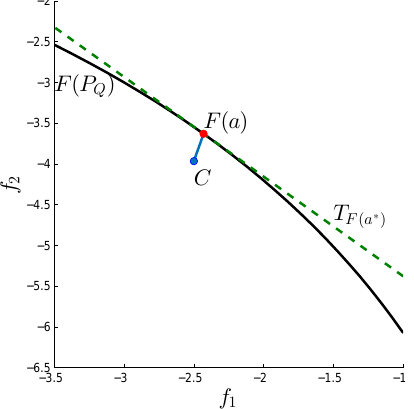
Figure 5. Geometric interpretation when F ( a l ) − C is orthogonal to the linearized Pareto